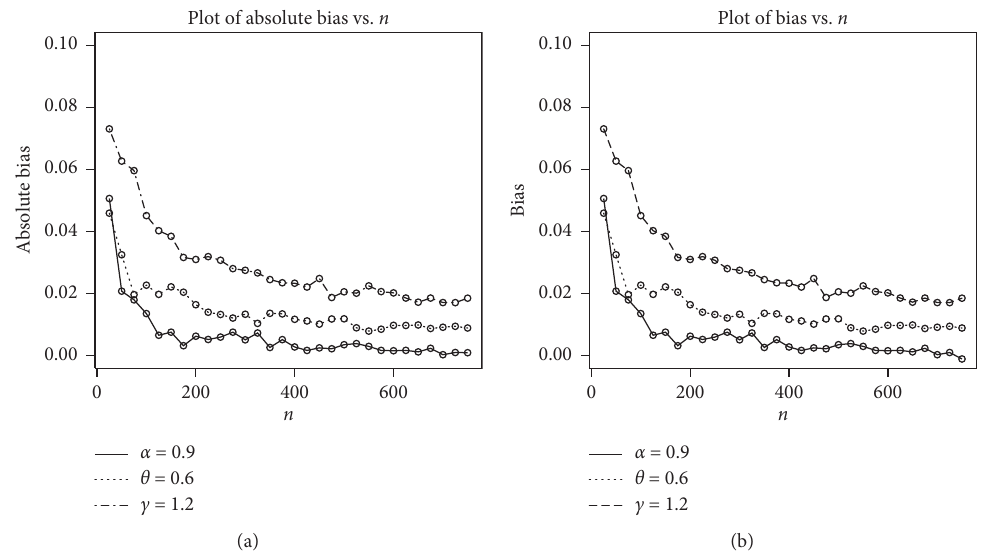
Figure 10: Biases and absolute biases plots of the NGE-Weibull distribution for α � 0 . 9, θ � 0 . 6, and c � 1 .